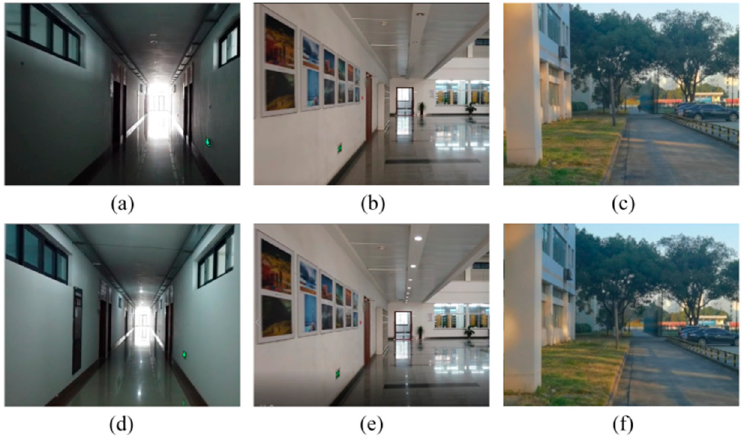
Figure 6. Three experimental scenarios. In ( a ) the corridor light is off; in ( b ) the library light is off; ( c ) is the first campus path; in ( d ) the corridor light is on; in ( e ) the library light is on; ( f ) is the second campus path.